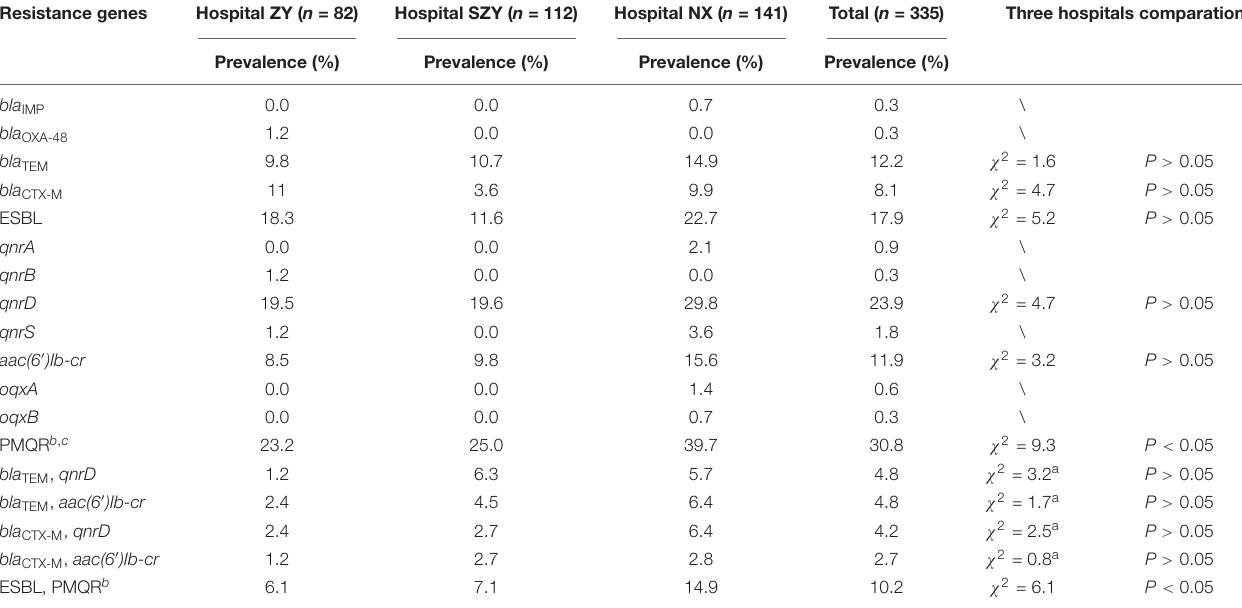
TABLE 1 | Prevalence of resistance genes in Morganella morganii clinical isolates. Resistance genes Hospital ZY ( n =